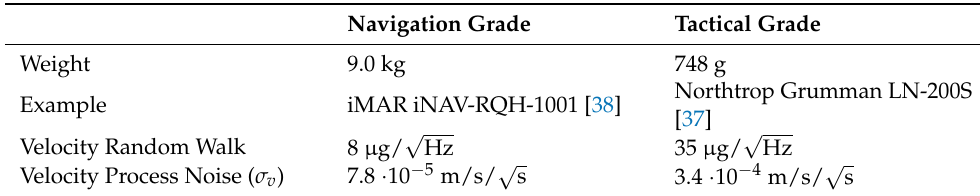
Table 4. Examples of different types of space-grade IMUs and their characteristics. Note that the velocity process noise considers a conservative integration time of 1 s.